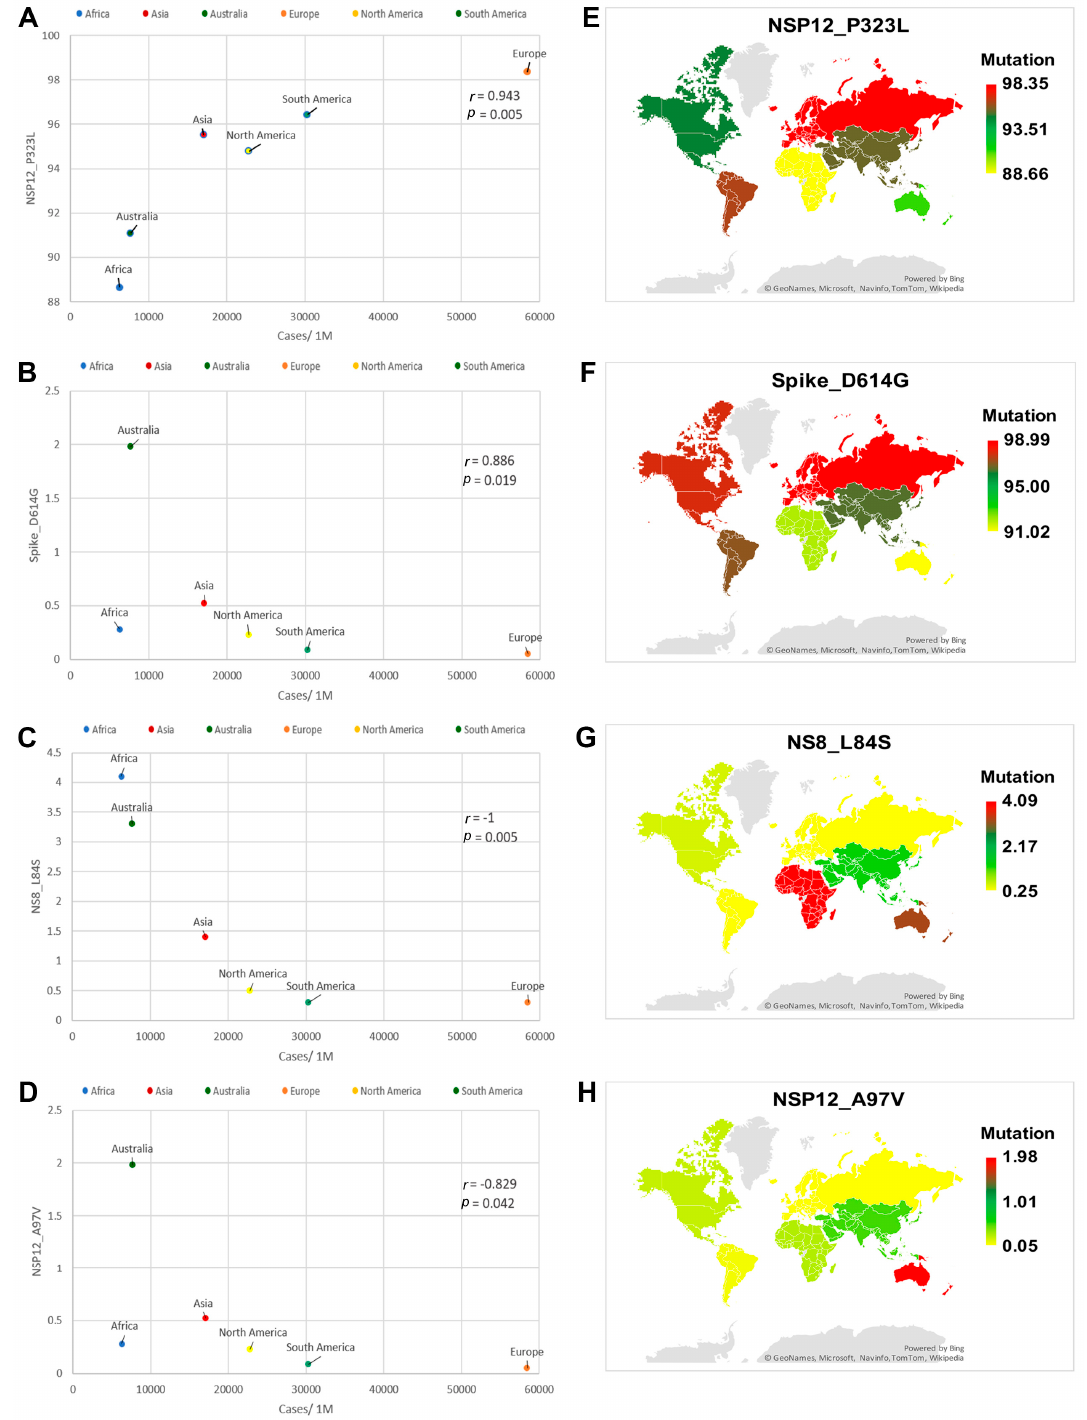
Figure 5. Correlation analysis and global mapping of mutations with cases per million among different world continents. ( A ) Spearman’s correlation between NSP12_P323L mutation and cases per million, ( B ) Spearman’s correlation between Spike_D614G mutation and cases per million ( C ) Spearman’s correlation between NS8_L84S mutation and cases per million. ( D ) Spearman’s correlation between NSP12_A97V mutation and cases per million. ( E ) Global mapping of NSP12_P323L mutation having a positive correlation with cases per million. ( F ) Global mapping of Spike_D614G mutation having a positive correlation with cases per million. ( G ) Global mapping of NS8_L84S mutation having a negative correlation with cases per million. ( H ) Global mapping of NSP12_A97V mutation having a negative correlation with cases per million. r: Spearman’s correlation coefficient. p : p